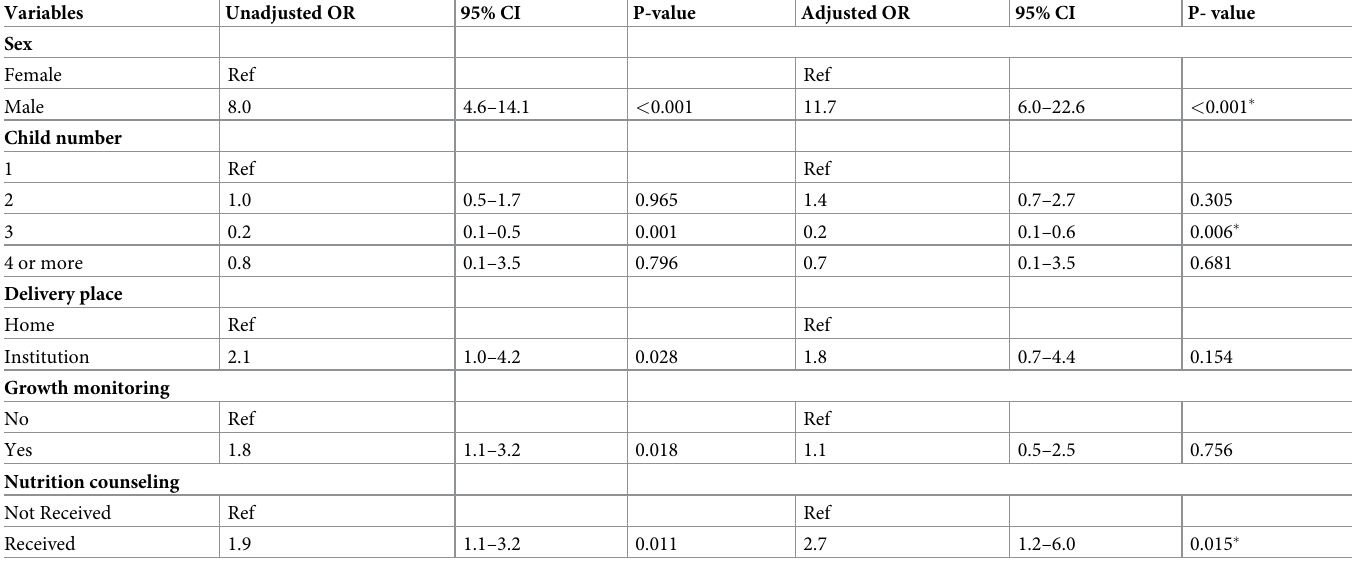
Table 6. Factors associated with timely initiation of complementary